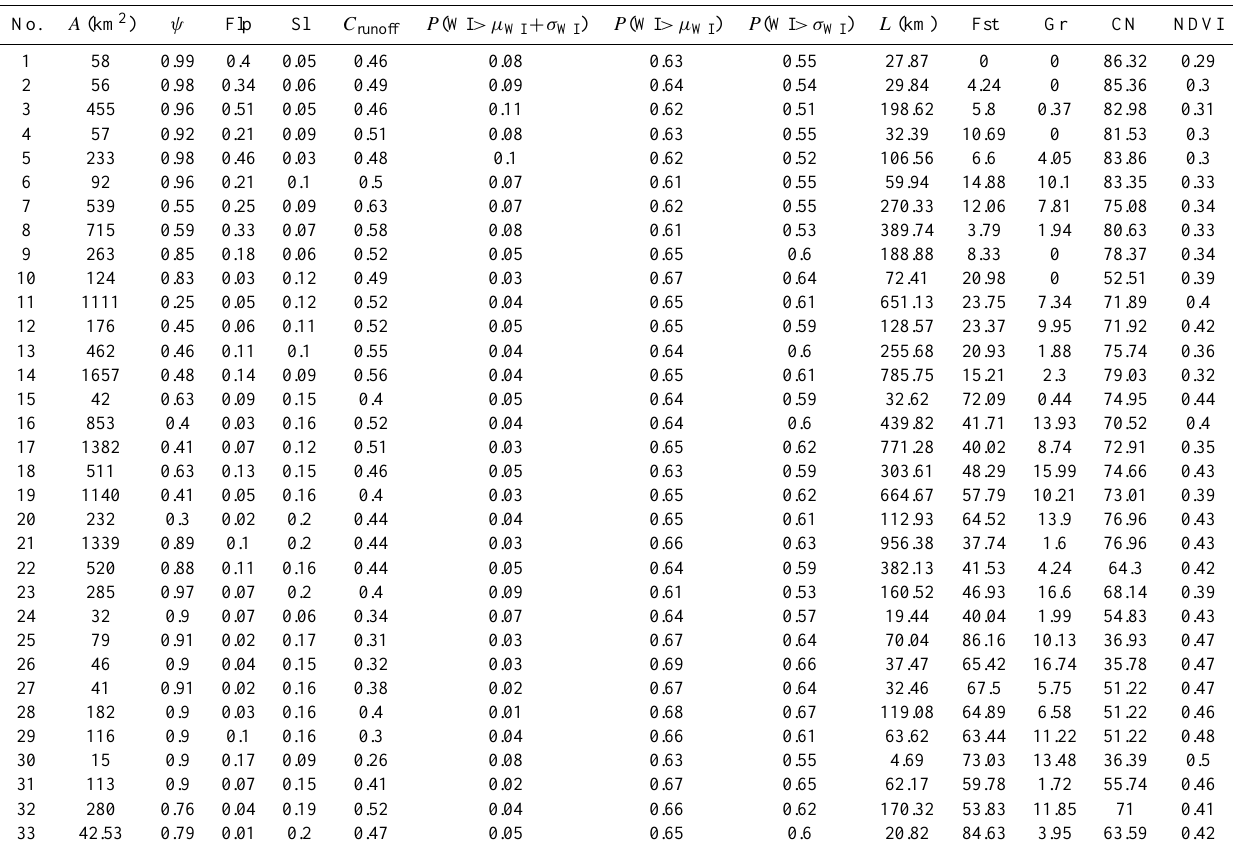
Table 2. Descriptors adopted for the regional parameter